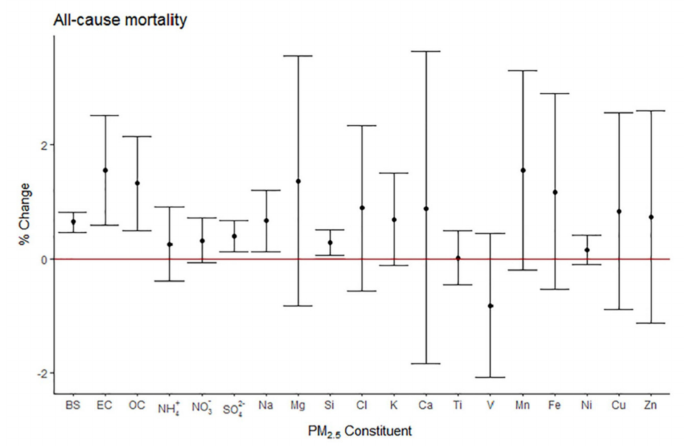
Figure 3. PM 2.5 constituent total mortality risk coefficients, shown as the 5th–95th percentile differ- ence in concentrations of PM 2.5 constituents (from [80]). (BS = black smoke; EC = elemental carbon; OC = organic carbon; NO 3 − = nitrate; SO 42 − = sulfate).